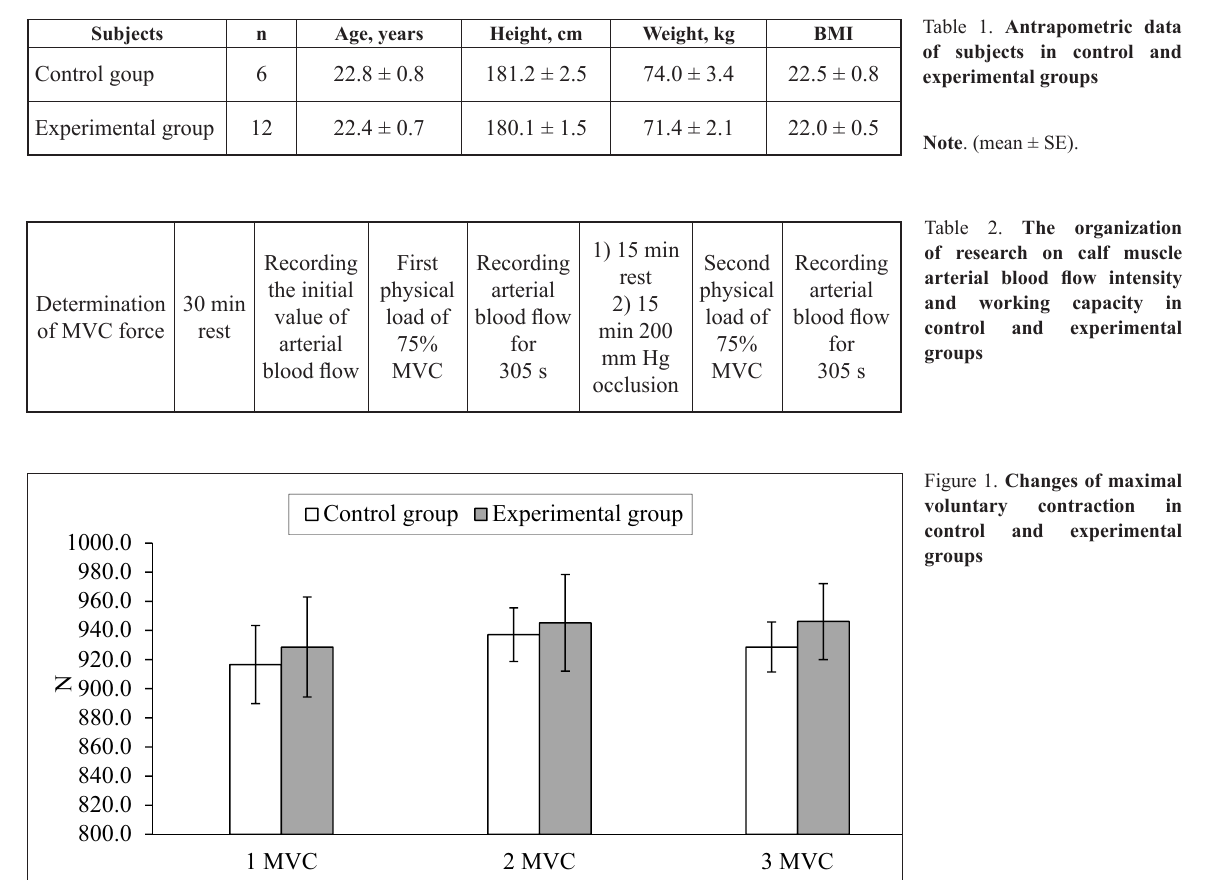
Table 1. Antrapometric data of subjects in control and experimental groups